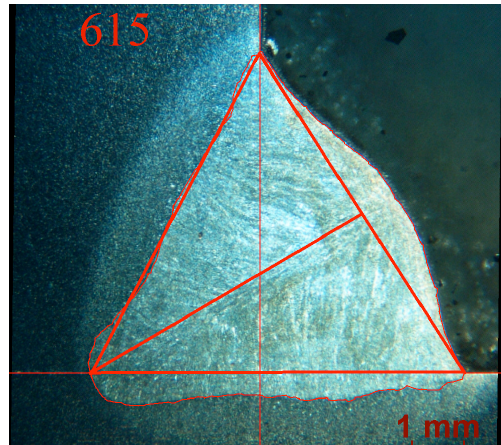
Fig. 8. Fillet deposited area P as a function of penetration z with constant throat size v